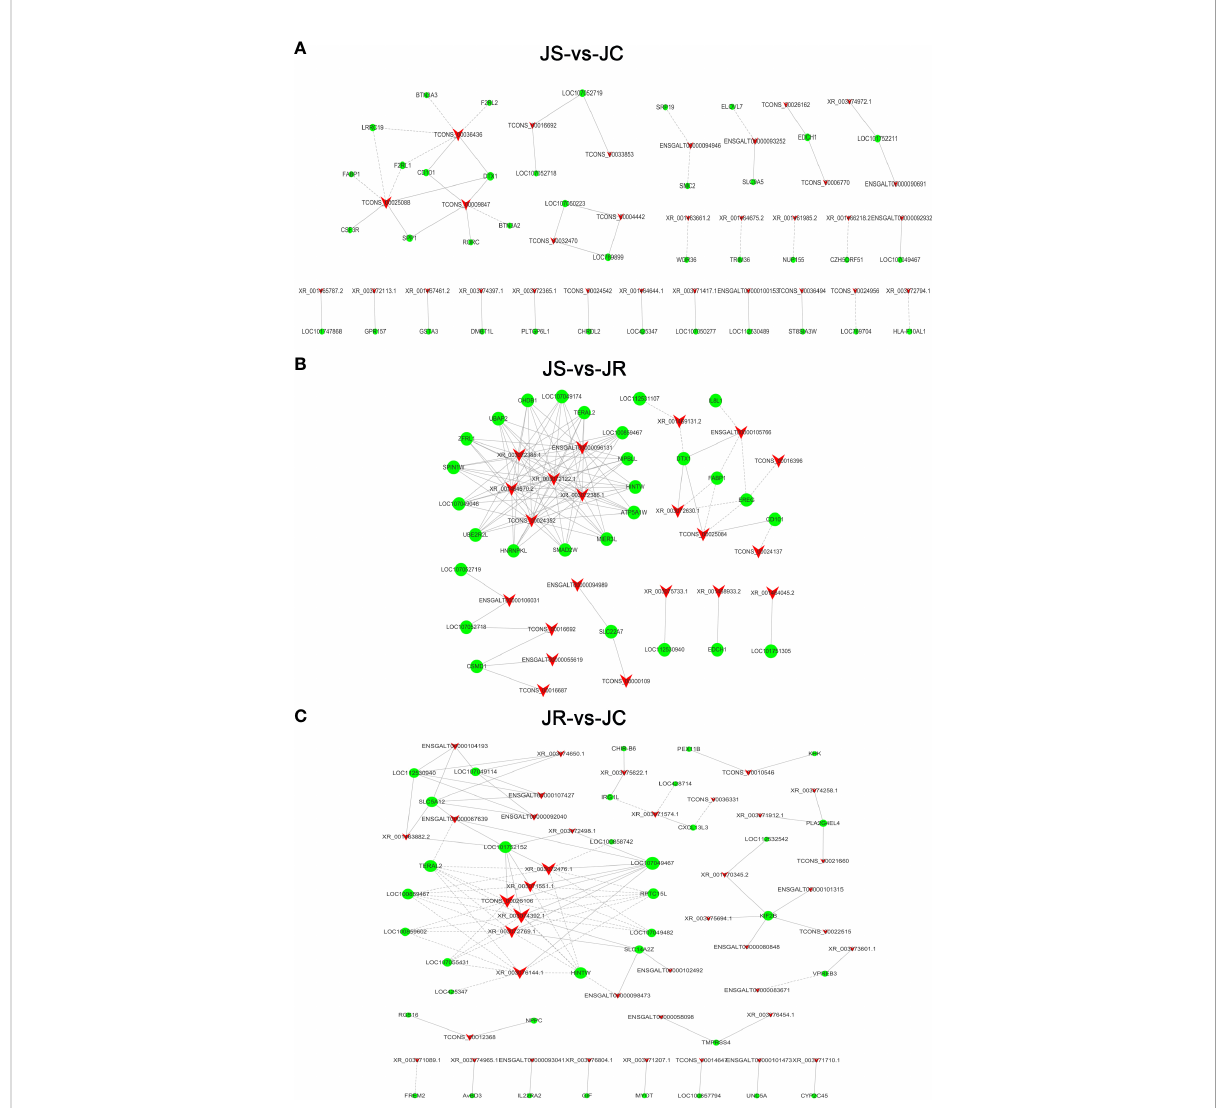
FIGURE 6 The coexpression network of differentially expressed lncRNAs and mRNAs. (A) JS vs JC groups. (B) JS vs JR groups. (C) JR vs JC groups. The solid lines indicate positive correlations, the dashed lines indicate negative correlations, the triangles represent the lncRNAs, and the circles represent the